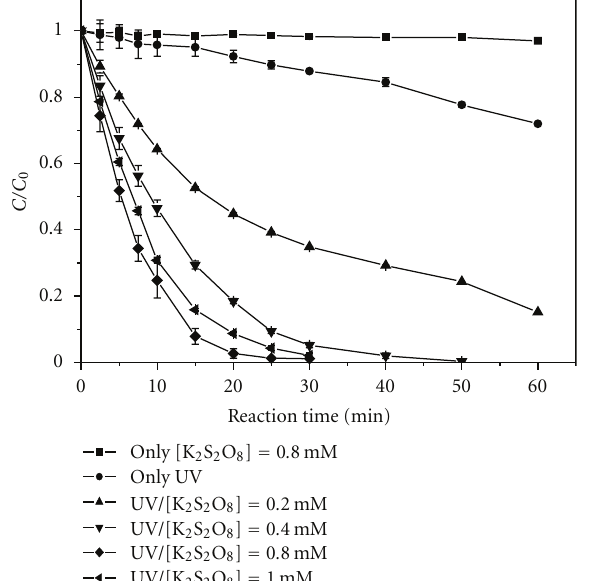
Figure 3: RhB degradation rate during UV/K 2 S 2 O 8 treatment system at di ff erent oxidant concentration. Conditions: [RhB] = 0.02mM, no pH adjustment.